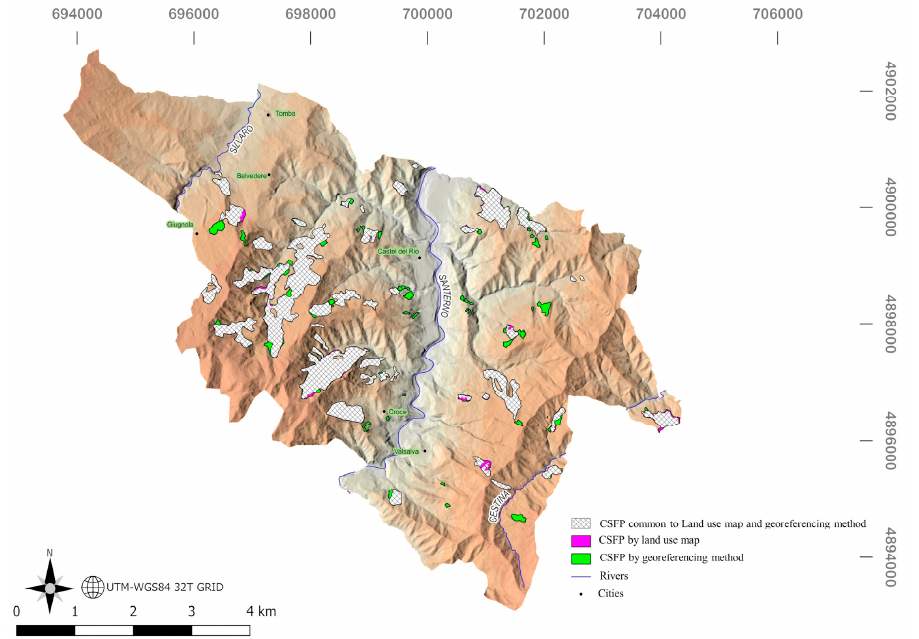
Figure 6. Map of Castel del Rio, Emilia-Romagna Region (Italy), showing the areas for chestnut stands for fruit production (CSFP) identified only with the land-use map (purple area), only with the georeferencing approach (green area), and with both methodologies (squared area).